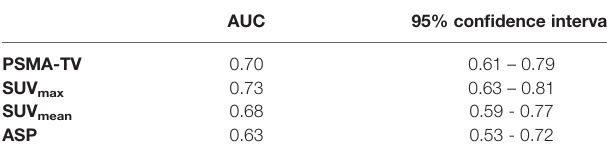
TABLE 3 | Area under the curve (AUC) characteristics for the investigated quantitative PSMA-PET parameters to detect high-risk prostate cancer. AUC